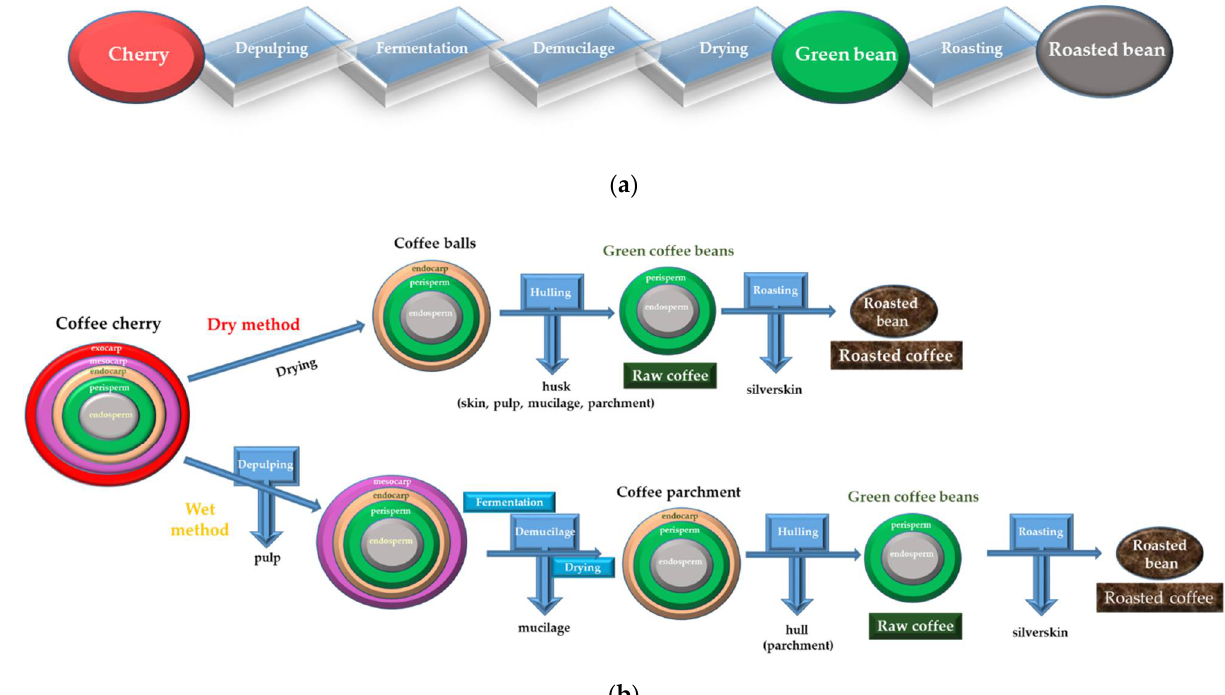
Figure 1. From coffee cherry to coffee bean. ( a ) The main steps followed to obtain coffee beans. ( b ) The fate of coffee fruit on the road to roasted beans. The structure of coffee cherry consists of the outer skin (pericarp), silverskin (perisperm) and coffee seed (endosperm). The pericarp represents the outer three layers of the fruit: the exocarp (pulp), mesocarp (mucilage) and endocarp (parchment) [4]. In the dry method (top) commonly used for Robusta varieties, the coffee cherries are sun-dried until the moisture content is between 10% and 12%. The dried cherries are called coffee balls. In the wet method (bottom), applied mainly for Arabica varieties, the cherries are de-pulped to remove the skin and pulp. The resulting beans remain covered with a gluey texture similar to honey, the mucilage, which is subsequently removed by fermentation. After washing and drying to moisture content 10% to 12%, the coffee parchment is obtained, which represents the coffee beans surrounded by their endocarp (parchment) and perisperm (silver skin). The hulling is the process where the hull (parchment, in the wet method) of the coffee parchment or husk of the coffee ball (in the dry method) is mechanically removed [24]. The green coffee beans are obtained after hulling, and in the next step, the green beans are sorted and roasted [25].